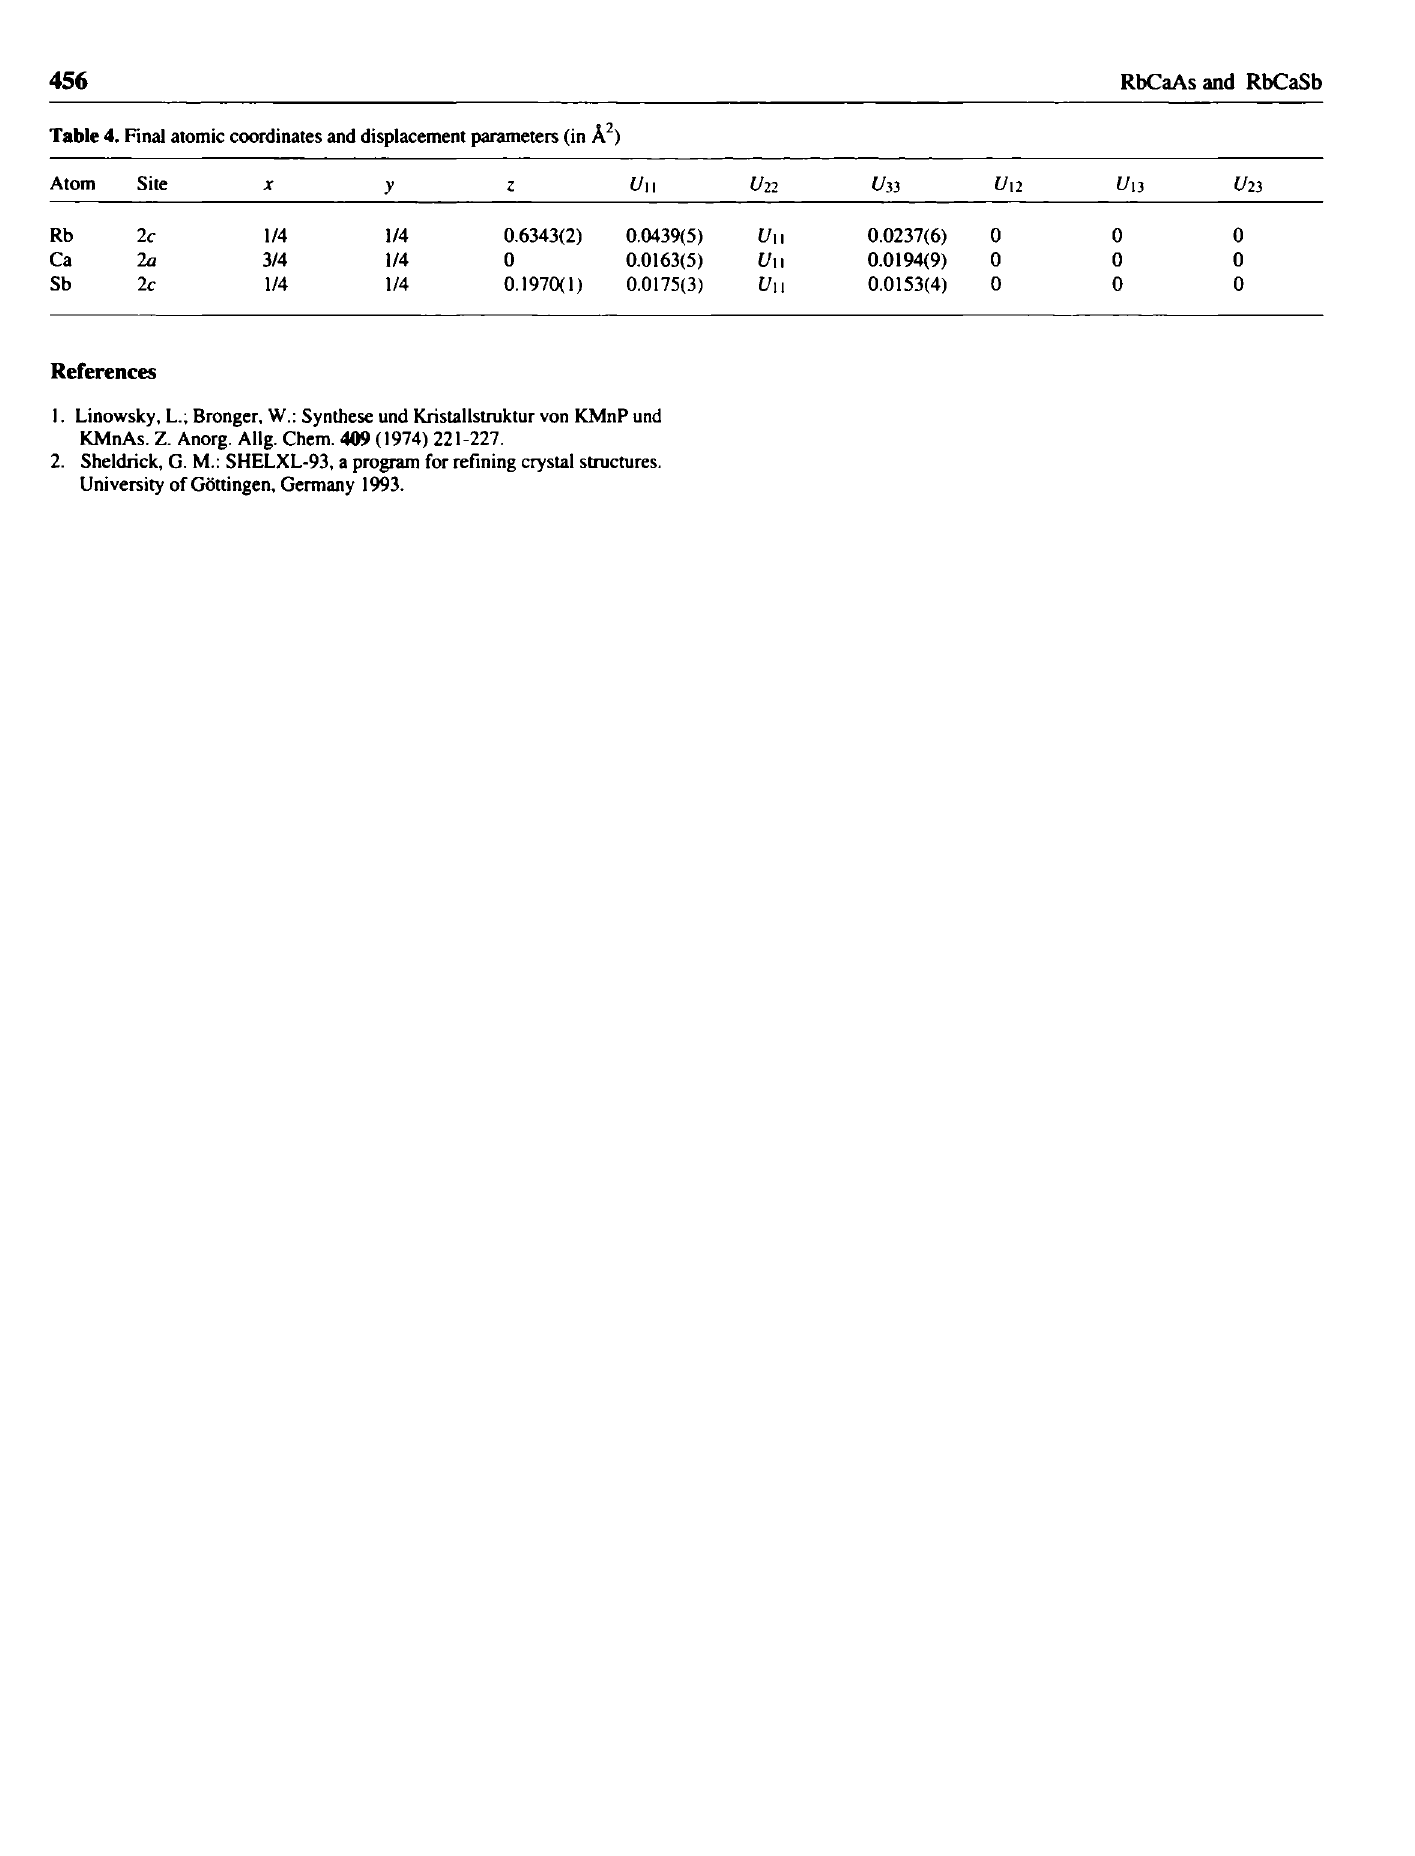
Table 4. Final atomic coordinates and displacement parameters (in Â^) Atom